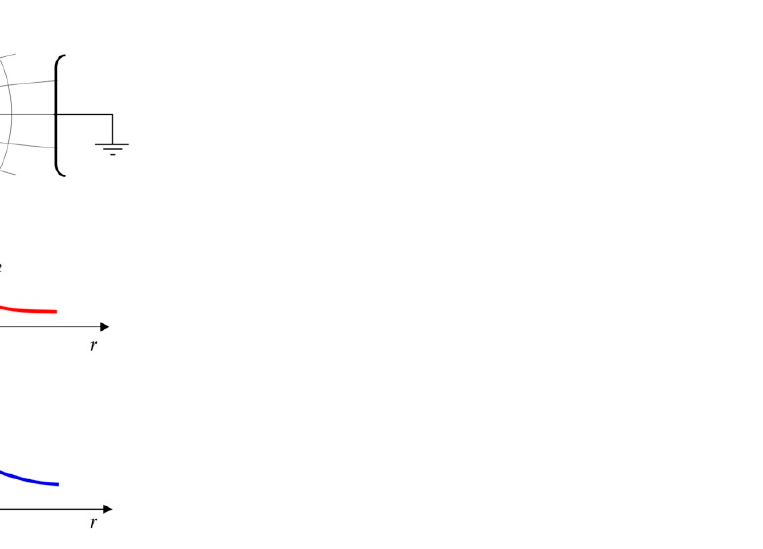
Figure 11. Distribution of electric field strength E and potential V in a heterogeneous sphere-to-plate system.